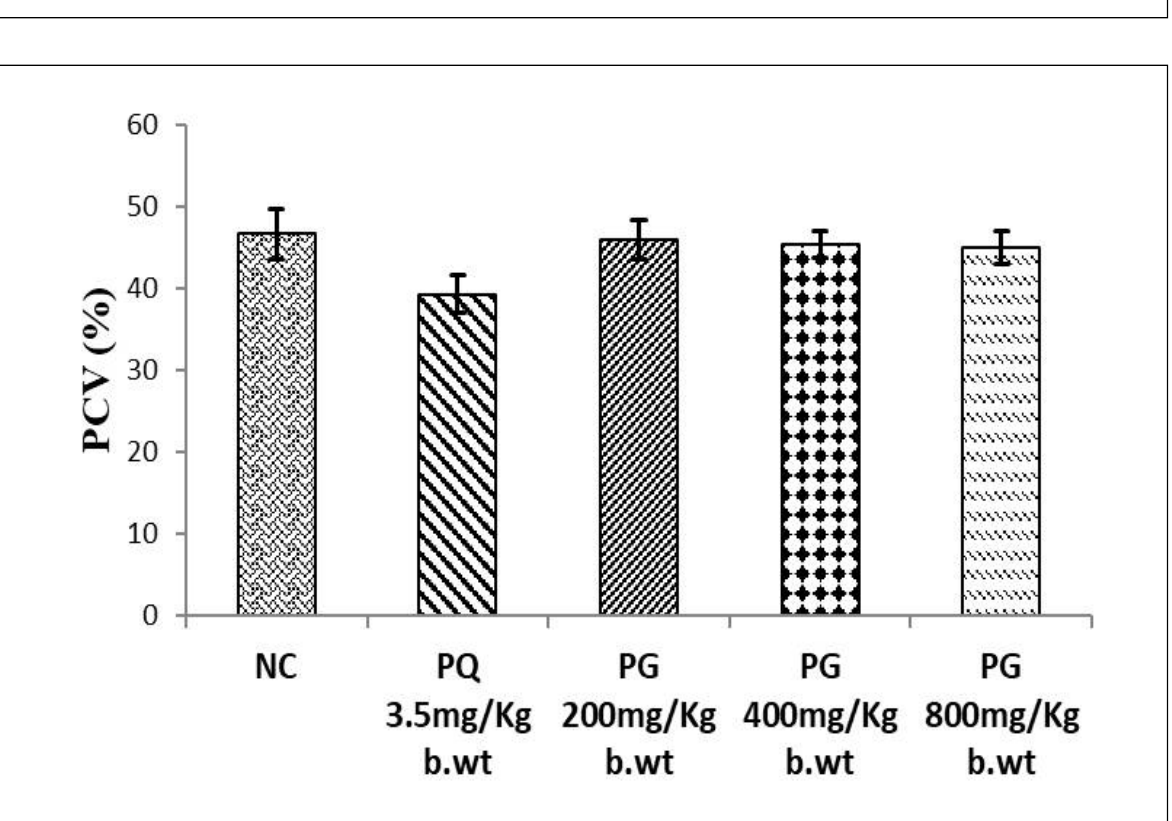
Figure 13: Effect of Psidium guajava leaf extract administration on packed cell volume of male wistar albino rats administered 3.5 mg/kg b.wt